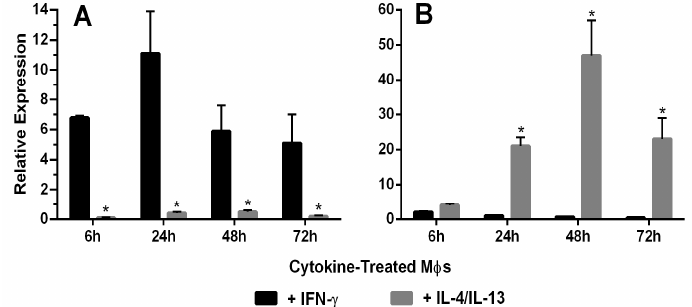
Figure 2. ( A ) Macrophage expression of the M1 marker iNOS. iNOS mRNA expression in rat peritoneal macrophages (M Φ ) treated with IFN- γ or IL-4/IL-13 for 6–72 h was characterized using qRT-PCR ( n = 5). The 65-, 28-, 13- and 19-fold differences between IFN- γ and IL-4/IL-13-treated macrophages were observed at 6, 24, 48 and 72 h, respectively (*: t test, p < 0.05). ( B ) Macrophage expression of the M2 marker Arg-1. Arg-1 mRNA expression by rat peritoneal macrophages treated with IFN- γ or IL-4/IL-13 for 6–72 h was characterized using qRT-PCR ( n = 5). The 32-, 135- and 265- fold differences were observed between IFN- γ and IL-4/IL-13-treated macrophages at 6, 24, 48 and 72 h, respectively (*: t test, p < 0.05).